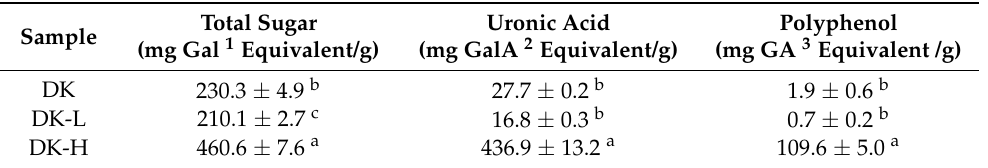
Table 1. Chemical composition of D. kaki extract (DK) and its low- and high-molecular-weight fractions (DK-L and DK-H,